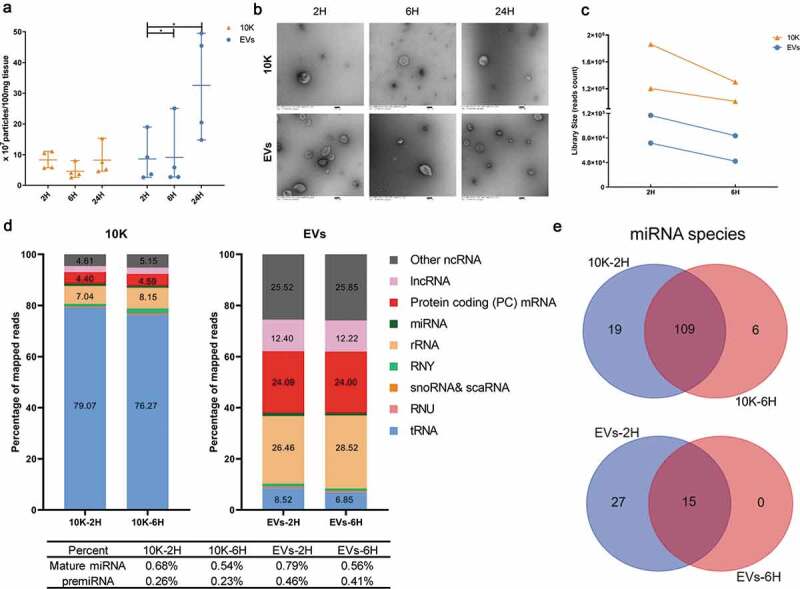
Effect of post-mortem interval on macaque bdEV separation. (a) Particle concentration of bdEV preparations by SEC+UC from 2 H, 6 H and 24 H post-mortem interval (PMI) macaque brains was measured by NTA (Particle Metrix, normalized per 100 mg tissue). Data are presented as the mean with range (n = 4). *p ≤ 0.05, **p ≤ 0.01, ***p ≤ 0.001, ****p ≤ 0.0001 by two-tailed Welch’s t-test. (b) BdEVs from 2 H, 6 H and 24 H PMI macaque brains were visualized by negative staining transmission electron microscopy (scale bar = 100 nm). TEM is representative of five images taken of each fraction from two independent tissue samples. (c) Small RNA sequencing; total reads from 10 K and EVs from 2 H and 6 H PMI (n = 2). (d) Average percent (n = 2) of mapped reads for the nine most abundant RNA classes in 10 K and EVs at 2 H and 6 H PMI. (e) Venn diagram of miRNAs (mean raw reads > 5) from two independent 10 K and EV preparations at 2 H and 6 H PMI.